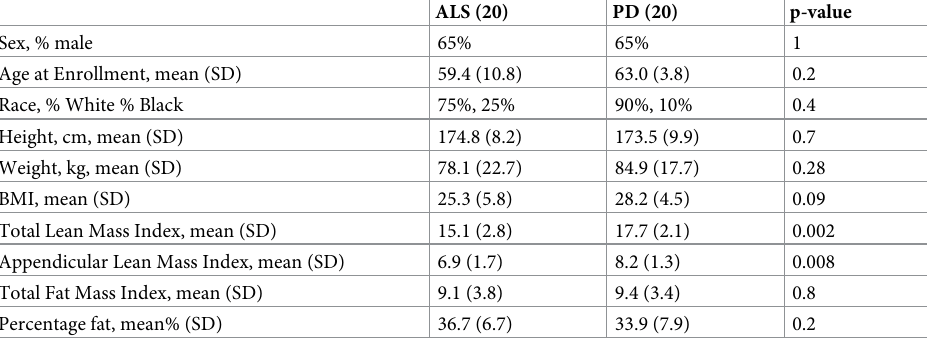
Table 1. Demographic and anthropometric characteristics of the study